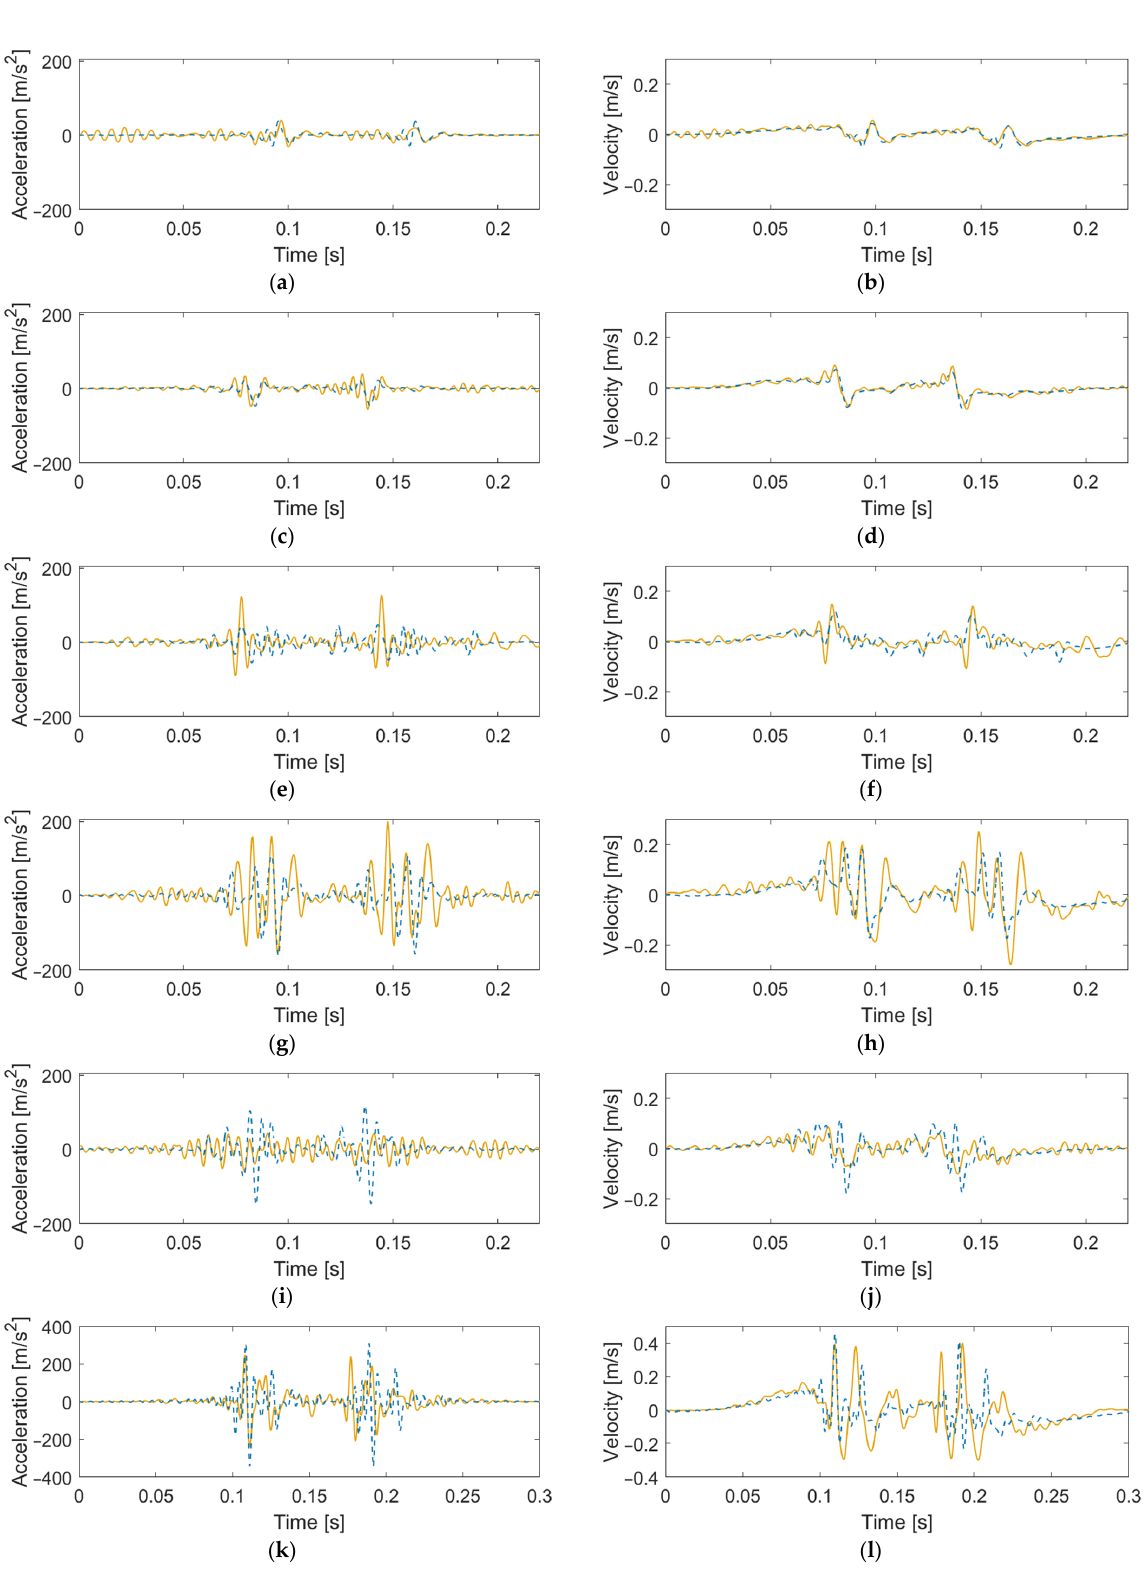
Figure 20. Examples of simulated (dashed line) and measured (continuous line) sleeper acceleration and velocity responses: ( a , b ) HO 21B, ( c , d ) HO 22A, ( e , f ) SG 21A, ( g , h ) SG 21B, ( i , j ) VAD 102, ( k , l ) VAD 131. Note different scale for VAD 131. Train speeds are 160 km/h for HO 21B, SG 21A, and SG 21B; 190 km/h for HO 22A, VAD 102; and 130 km/h for VAD